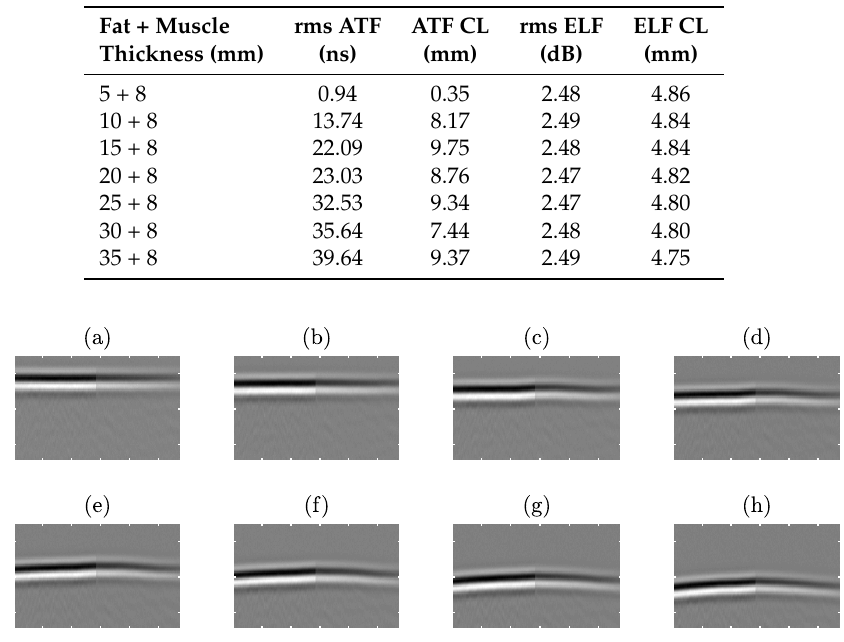
Table 2. Aberration parameters. Root-mean-squared (rms) values and full-width at half-maximum correlation lengths (CL) of arrival time and energy level fluctuations (ATF and ELF, respectively).